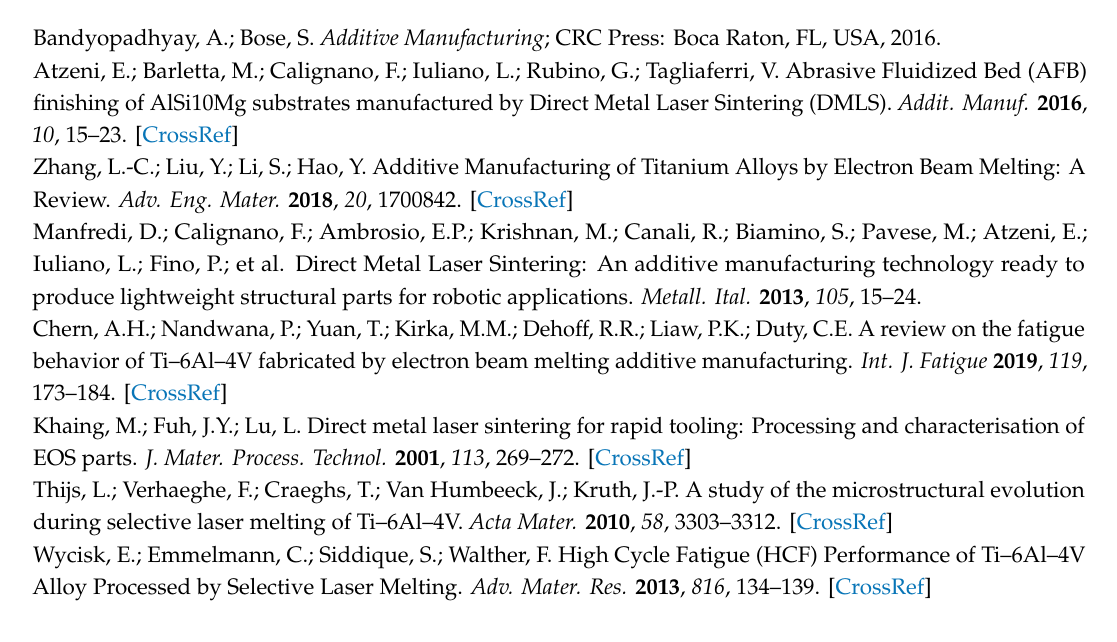
Figure 15. Microstructure analysis of ( a ) as-built and ( b ) laser-polished samples.